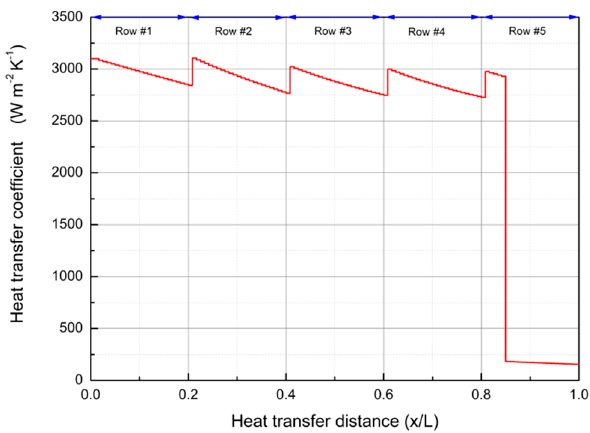
Figure 11. Heat transfer coefficient of CO 2 mixture variation in the heat exchanger.